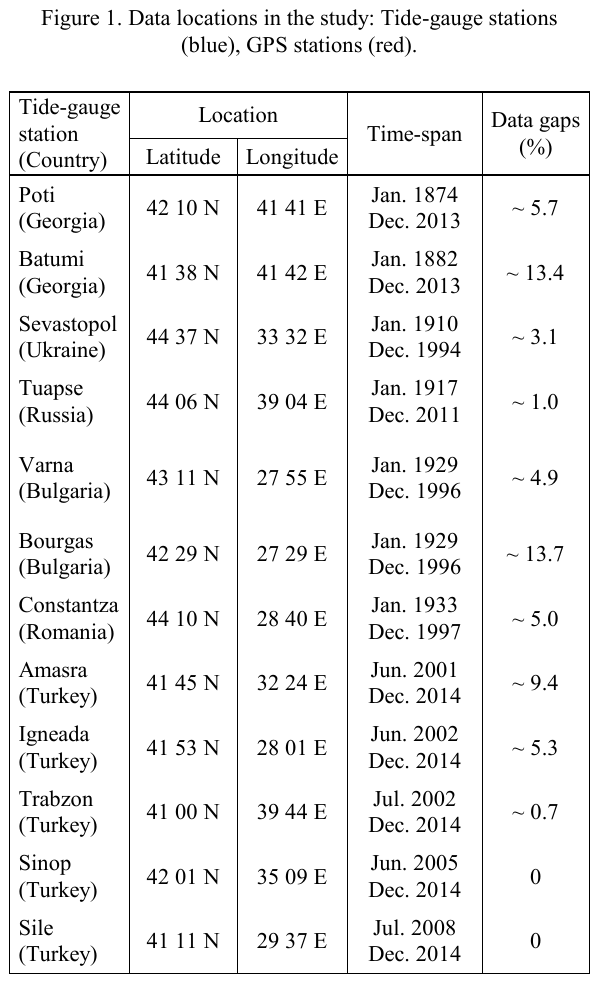
Table 1. General information on all the tide-gauge stations used in this study.